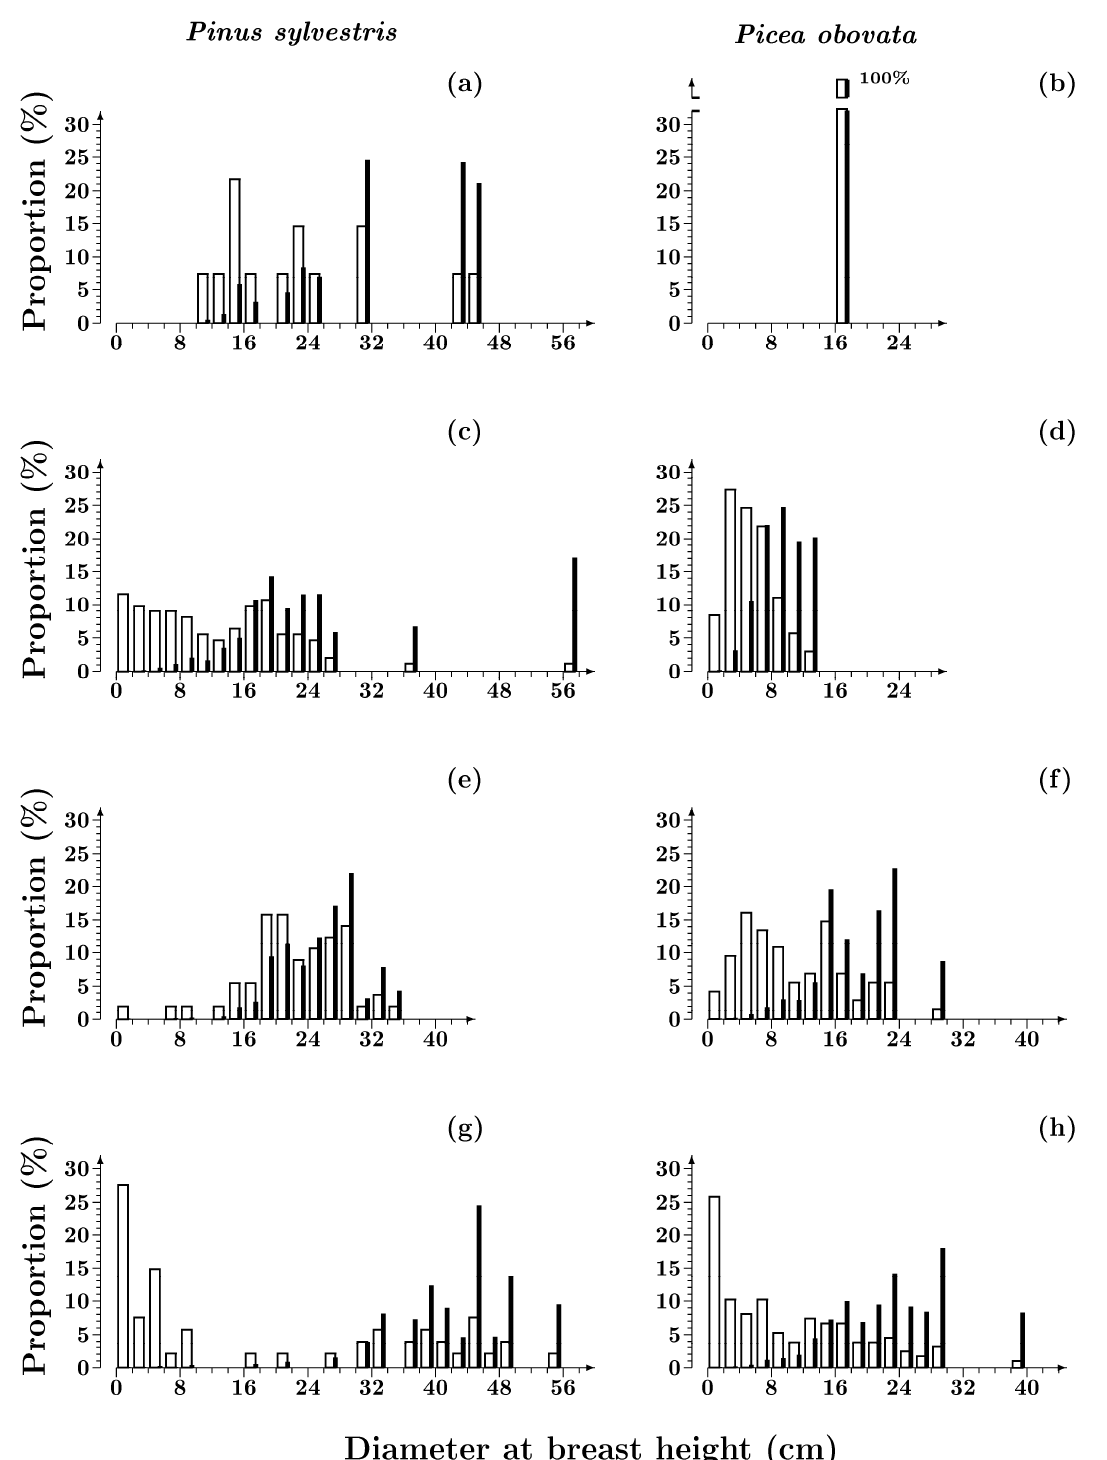
Figure 1. Diameter class distributions of Pinus sylvestris and Picea obovata trees in Siberian spruce–Scots pine forests with a post-fire period of 8 ( a, b ), 80 ( c, d ), 150 ( e, f ) and 380 ( g, h ) years. Open bars—by number of individuals; solid bars—by volume.